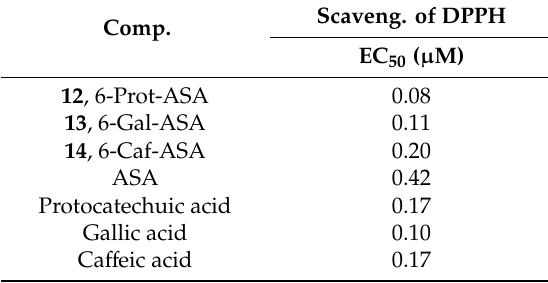
Table 3. The antioxidant properties of ASA phenolic esters determined by the DPPH assay. Comp.